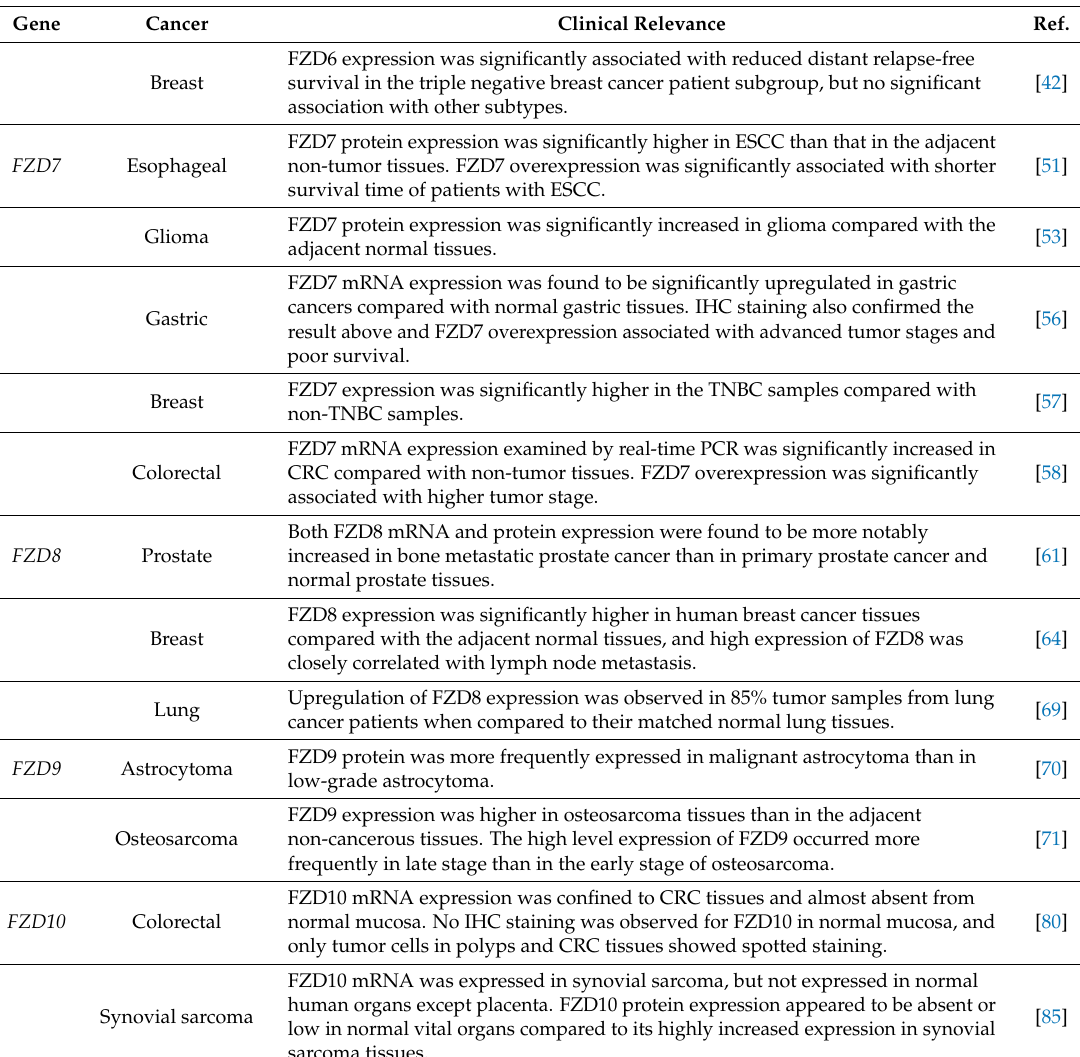
Clinical Relevance